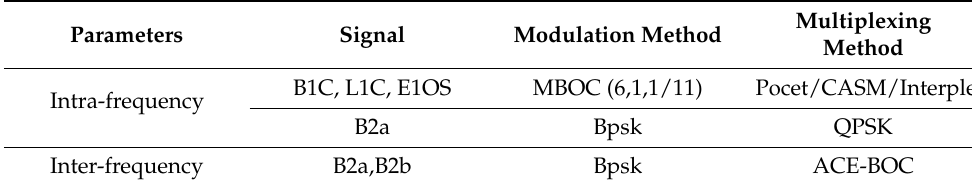
Table 1. Representative signals of GNSS joint